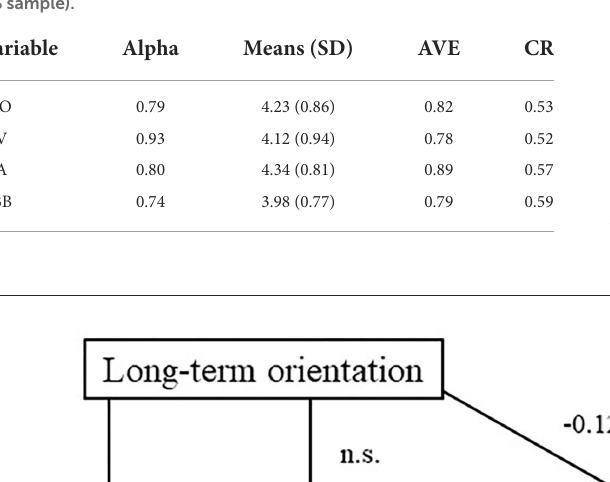
TABLE 4 Scale reliability levels ( α ), means, standard deviations (SD), average variance extracted (AVE), and composite reliabilities (CR) (The US sample).